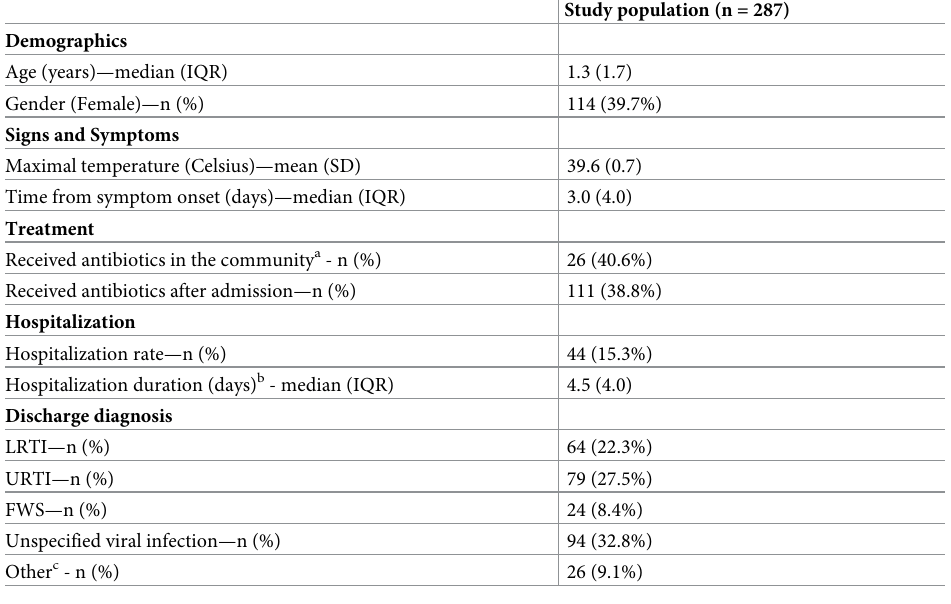
Table 1. Demographics of study population (n =